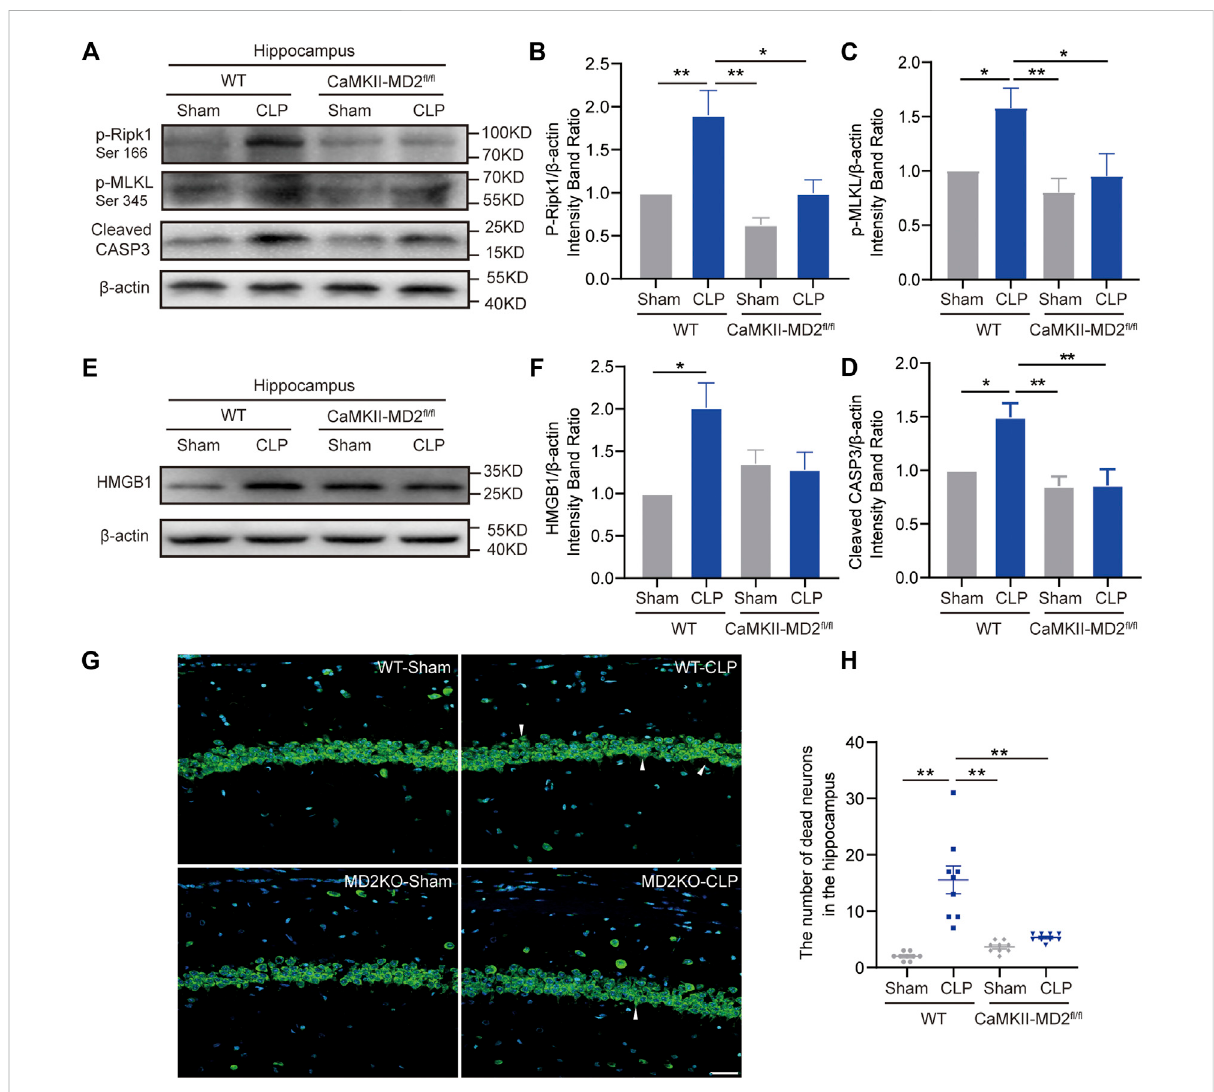
FIGURE 5 MD2synchronouslyregulatedapoptosisandnecroptosisinhippocampalneurons,andinhibitionofMD2reducedcelldeath. (A) .Representative Western blots of p-Ripk1, p-MLKL and cleaved caspase-3 in different groups. (B) . Quantitative evaluation of p-Ripk1 expression. (C) . Quantitative evaluation of p-MLKL expression. (D) . Quantitative evaluation of cleaved caspase-3 expression 24 h after CLP in different groups. * p < 0.05, ** p < 0.01 vs . the CLP-WT group. Data are shown as the mean ± SEM ( n = 8). (E) . Representative Western blot of HMGB1 24 h after CLP. (F) . Quantitative evaluation of HMGB1 24 h after CLP. * p < 0.05. Data are shown as the mean ± SEM (n = 8). (G) . NeuroTrace ™ Nissl staining in the hippocampus at 14 days of CLP (bar = 30 μ m). (H) . The number of dead neurons in the hippocampus among different groups. ** p < 0.01. Data are shown as the mean ± SEM ( n =